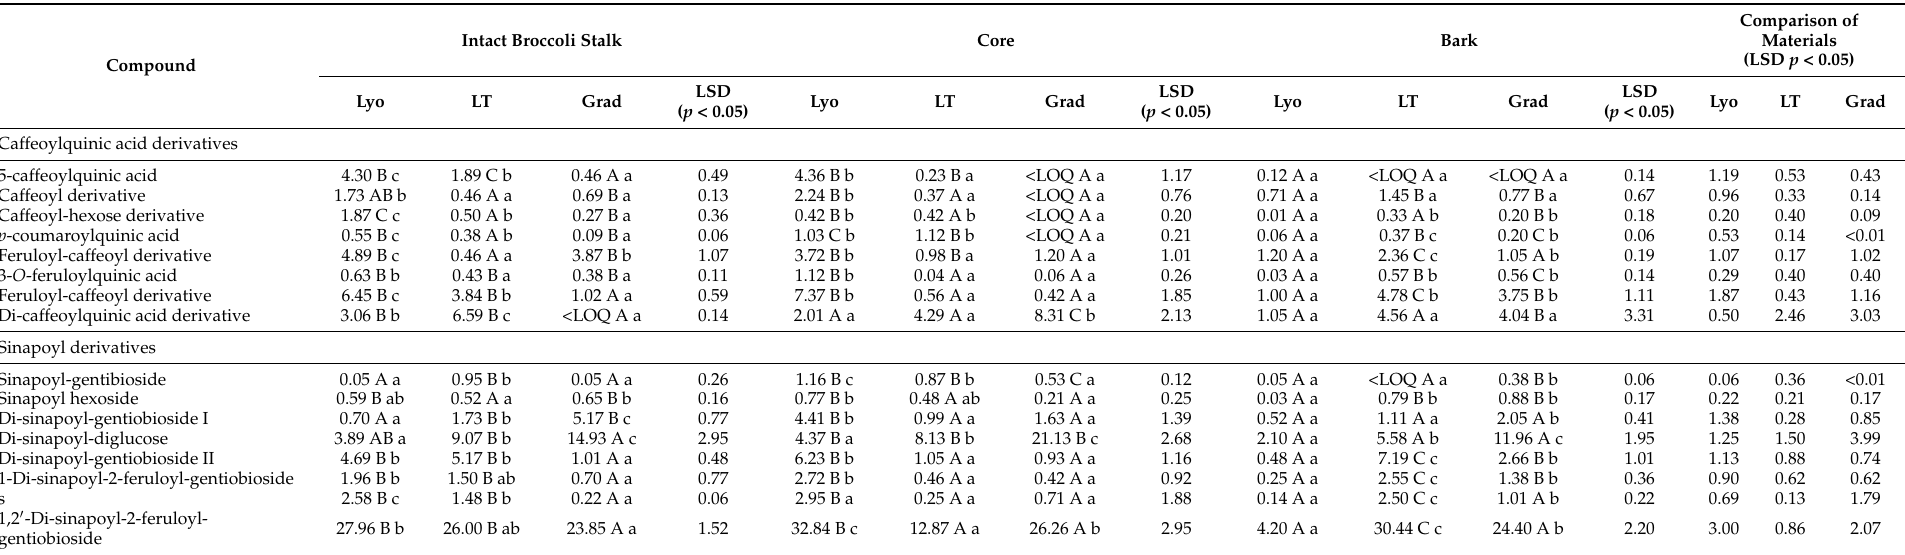
Bars represent mean ± SD ( n = 3). Bars with different lowercase letters are significantly different at p < 0.05 according to a one-way analysis of variance (ANOVA) and a multiple range test of Tukey. Lyo, lyophilization; LT, low-temperature drying; Grad, Decreasing temperature gradient. Different lowercase letters indicate significant differences between processing conditions for the same material and distinct capital letters indicate differences between materials for different processing